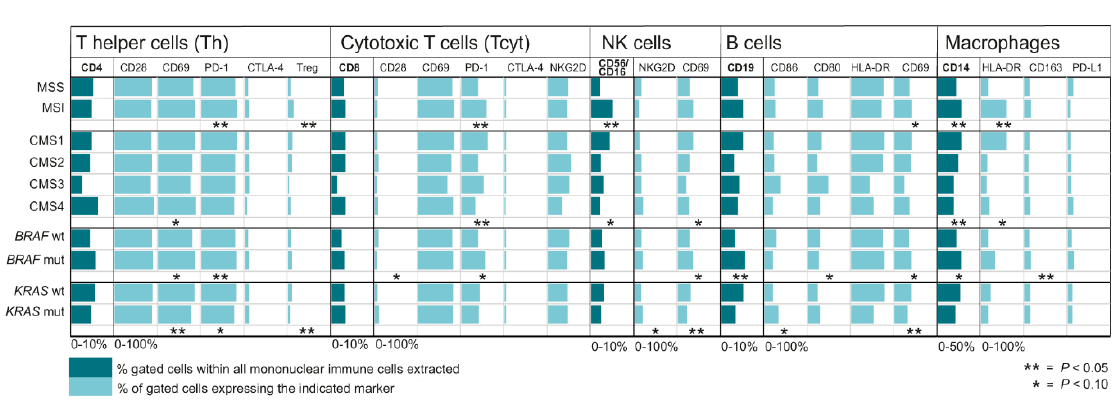
Figure 2. Shown is median percentage of gated cell populations in mononuclear immune cells (in dark blue) isolated from tumour tissue of patients with colorectal cancer, and percentage of these gated cells expressing the indicated markers (in light blue). * indicate p -values < 0.10 and ** indicate p -values < 0.05.